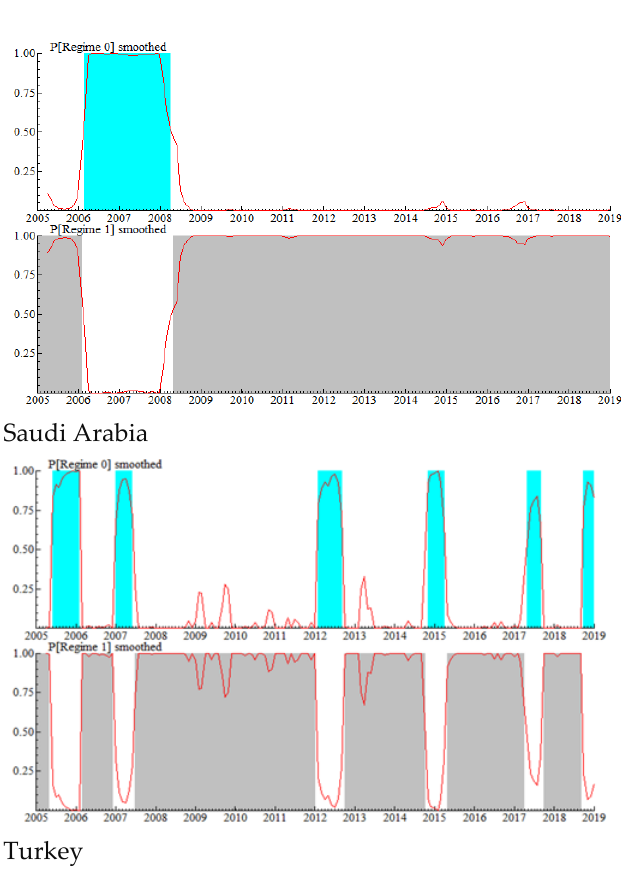
Figure 3. Smoothed transition probabilities.